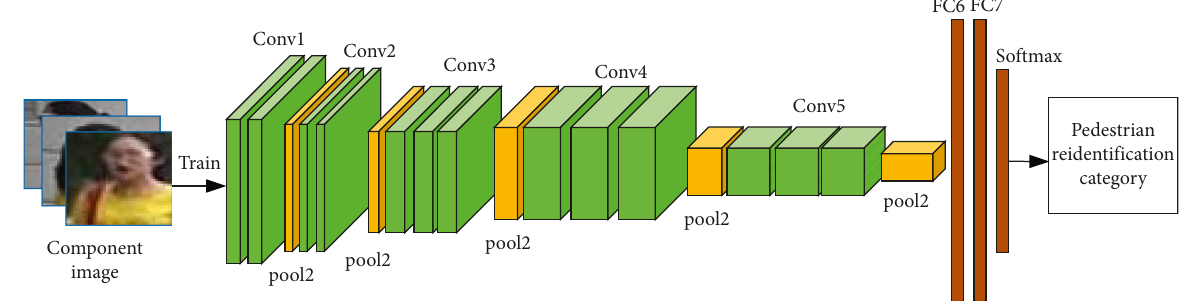
Figure 3: Schematic diagram of feature